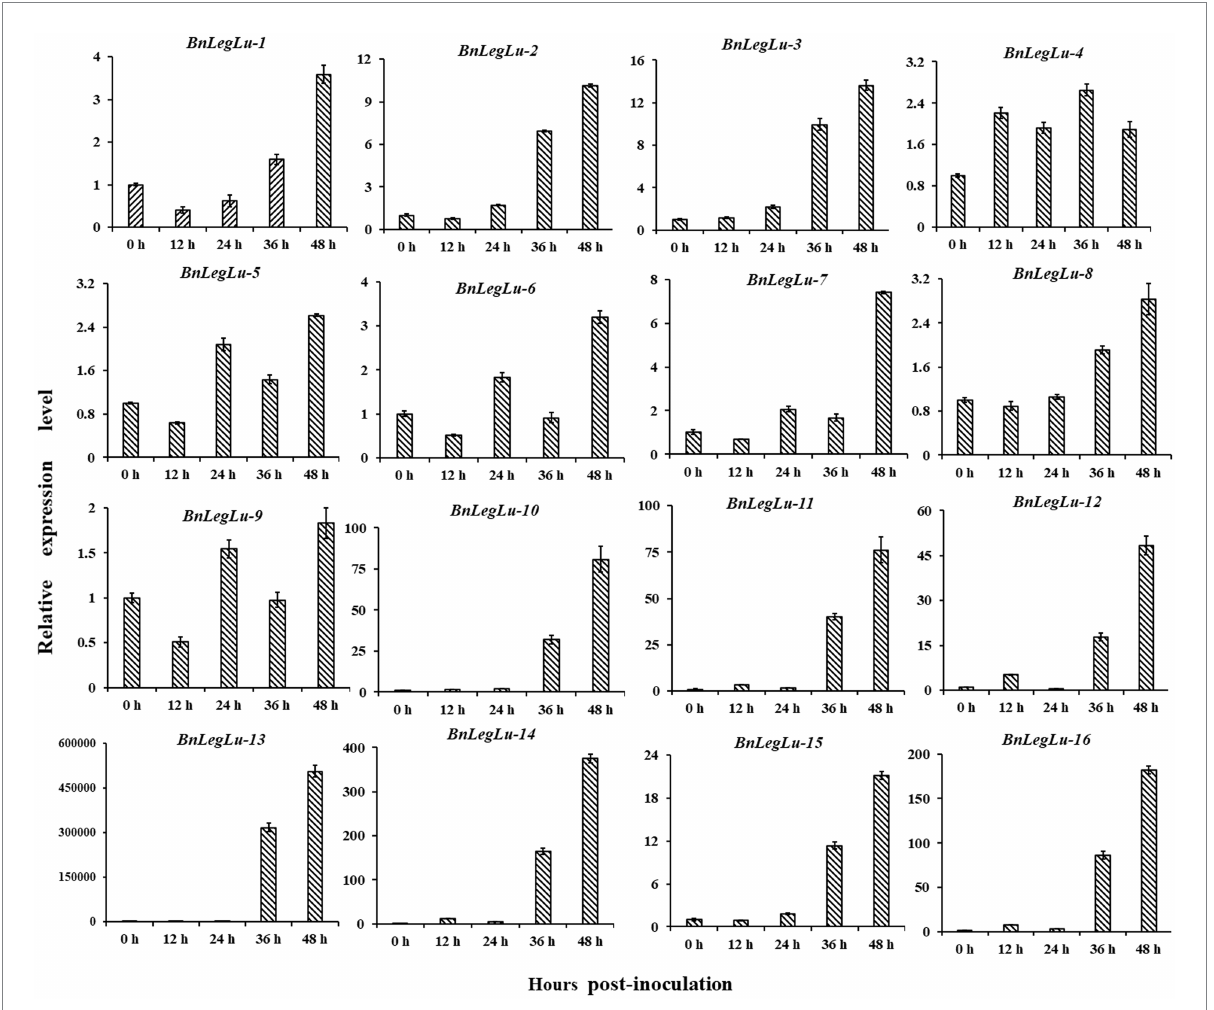
FIGURE 6 Expression validation of 16 candidate BnLegLu genes in response to S. sclerotiorum determined by qRT-PCR. The time points 0, 12, 24, 36 and 48 h represent hours after inoculation with S. sclerotiorum . The error bars show the standard error of three